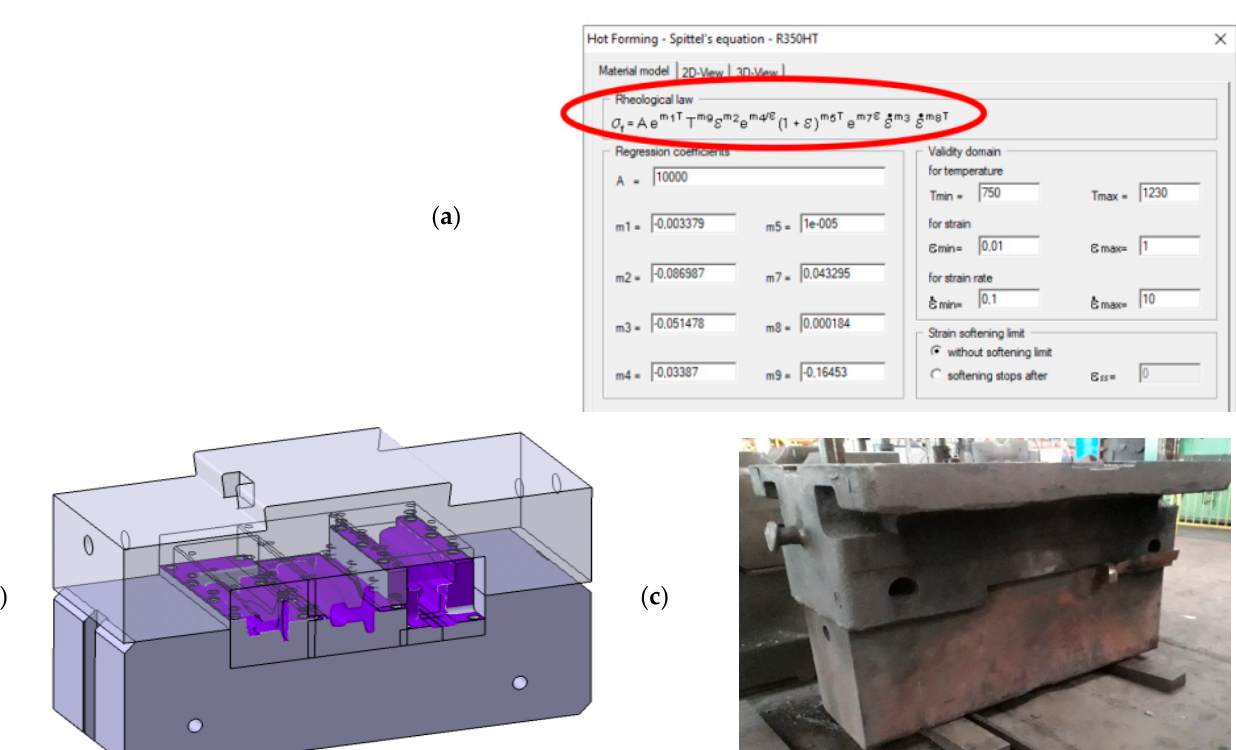
Figure 13. View of: ( a ) a screen from the program with the Spittel equation and the determined coefficients, ( b ) the CAD model of the particular tools fixed in the anvils, ( c ) a photo of the lower holder for reforging needle rails before modernization.